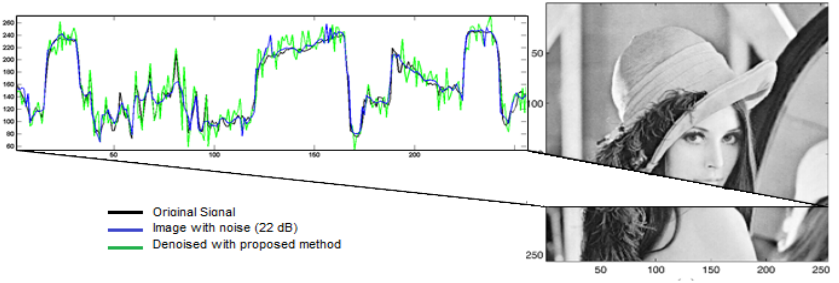
Figure 12. Row 200 of Image, with Gaussian white noise (Input PSNR = 22.11 dB) and denoised with proposed Method (27.93 dB).